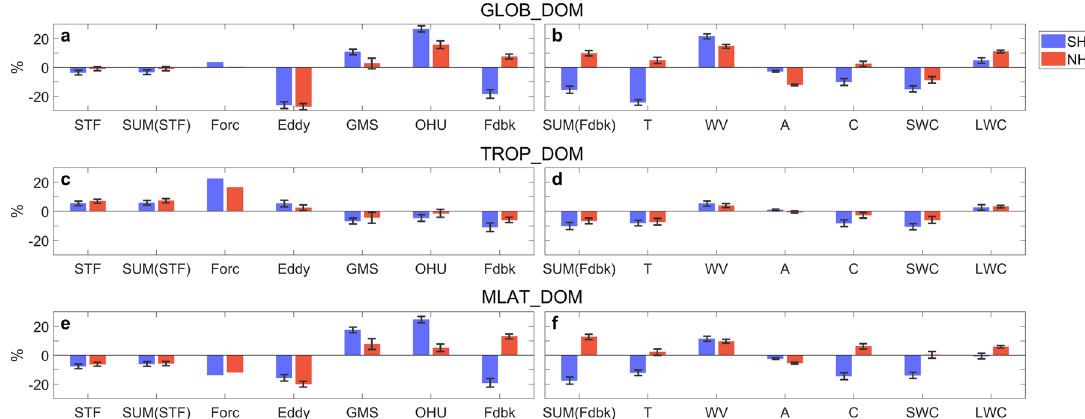
Fig. 4 Decomposition of Hadley circulation intensity responses to different CO 2 forcings. Contributions to changes (unit = %) in the northern (red) and southern (blue) Hadley cell intensity for a , b GLOB_DOM, c , d TROP_DOM, and e , f MLAT_DOM. Fractional changes in Hadley cell intensity (STF), contributions from radiative forcing (Forc), atmospheric eddies (Eddy), gross moist stability (GMS), ocean heat uptake (OHU), and radiative feedback (Fdbk) (see ‘ Methods ’ ). The summation of all contributions (SUM(STF)) matches well the actual response STF, validating the linear decomposition using Eq. (5). (Right) The Fdbk contributions due to changes in temperature (T), water vapor (WV), surface albedo (A), net cloud feedback (C), and the shortwave (SWC) and longwave (LWC) components of the cloud feedback. The summation of all feedback components (SUM(Fdbk)) matches well with Fdbk, validating the radiative fl ux decomposition using Eq. (6). Error bars indicate the con fi dence intervals in which the responses are statistically not different from the control simulation at the 95% con fi dence level based on a two-tailed t